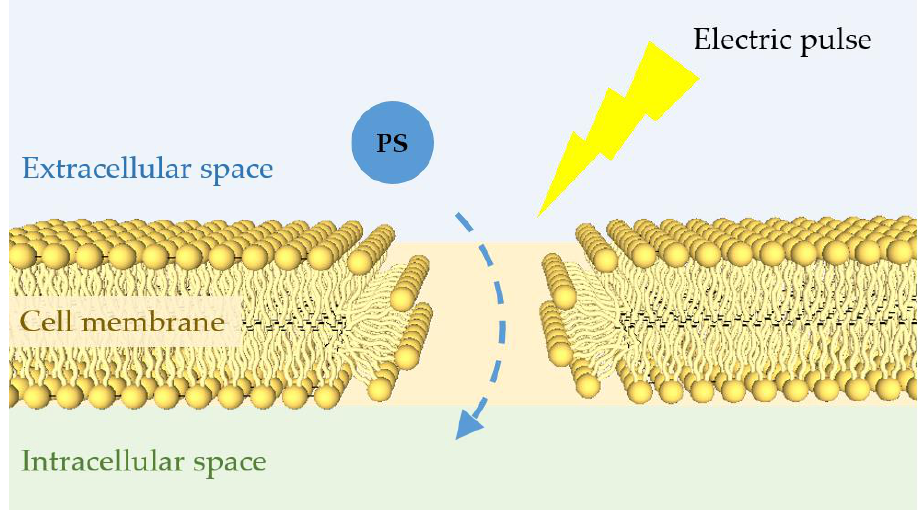
Figure 7. Schematic of the electroporation effect. A short external electric pulse of high voltage can affect the organization of the cell membrane generating non-selective pores. These pores allow the transport of PS into the cell and thus enhance the PDT effect.